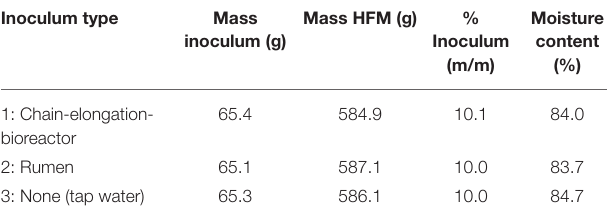
TABLE 1 | Initial conditions for Experiment